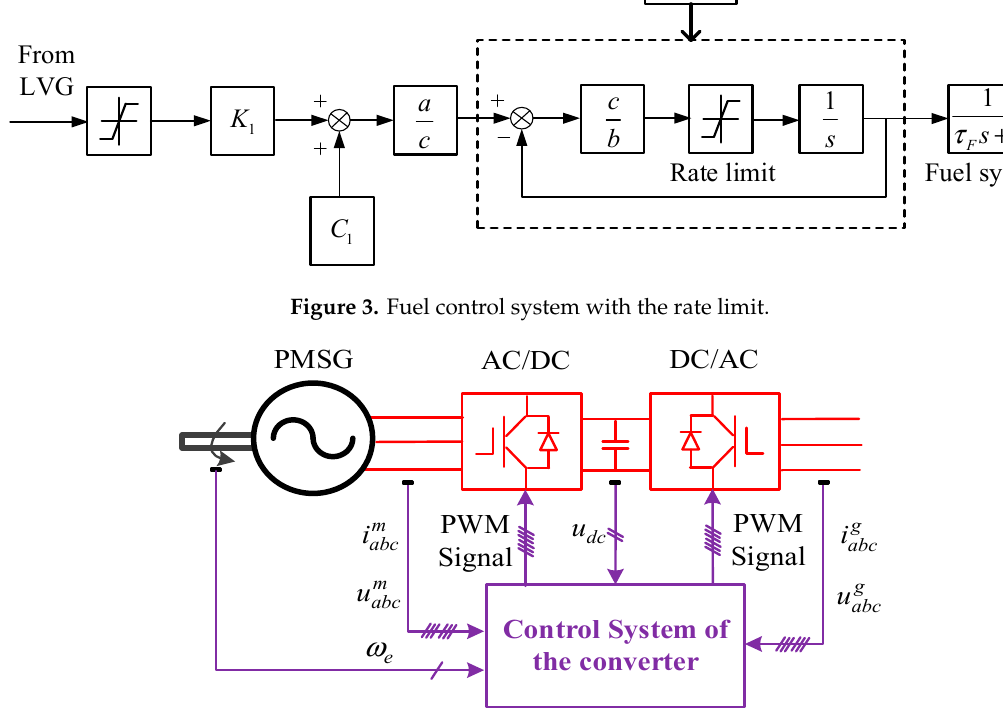
Figure 3. Fuel control system with the rate limit.